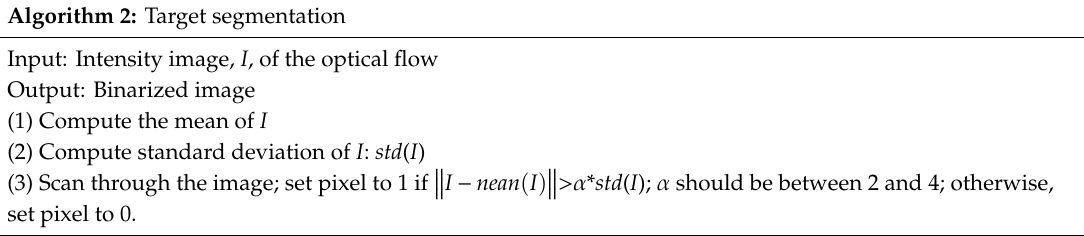
Algorithm 2: Target